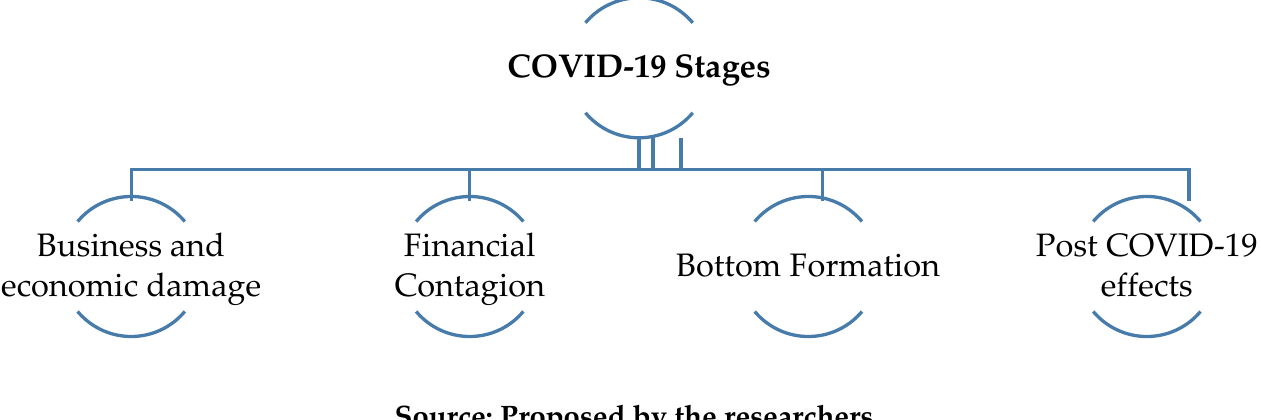
Figure 1. Four stage model for economic impact of COVID-19.